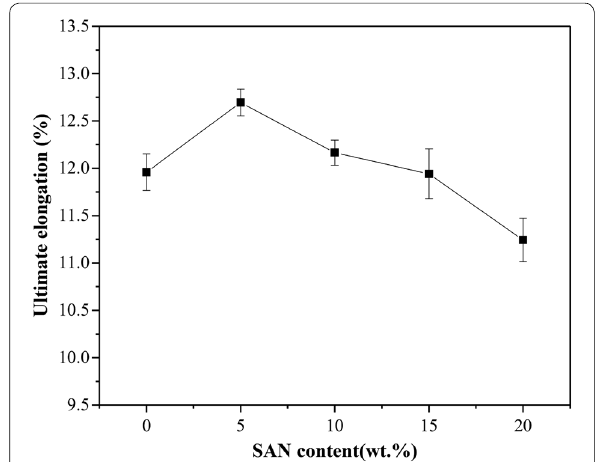
Fig. 10 Ultimate elongation of PP and SAN/PP